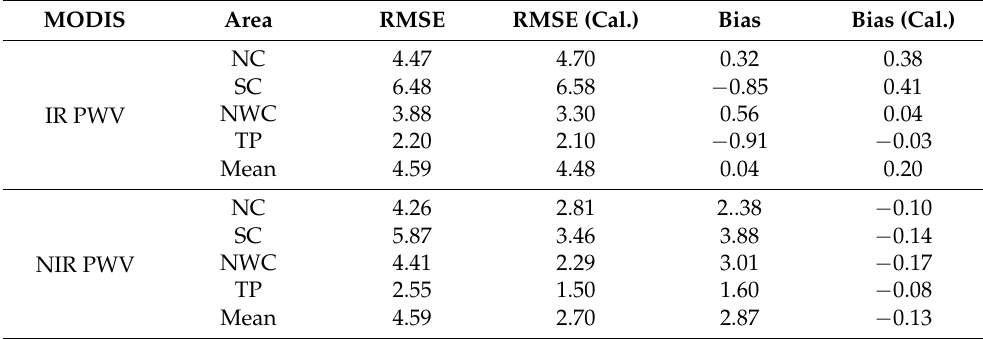
Table 6. Statistical result of MODIS PWV with and without calibration over the period of 2011–2017 in the four areas of China (unit: mm).